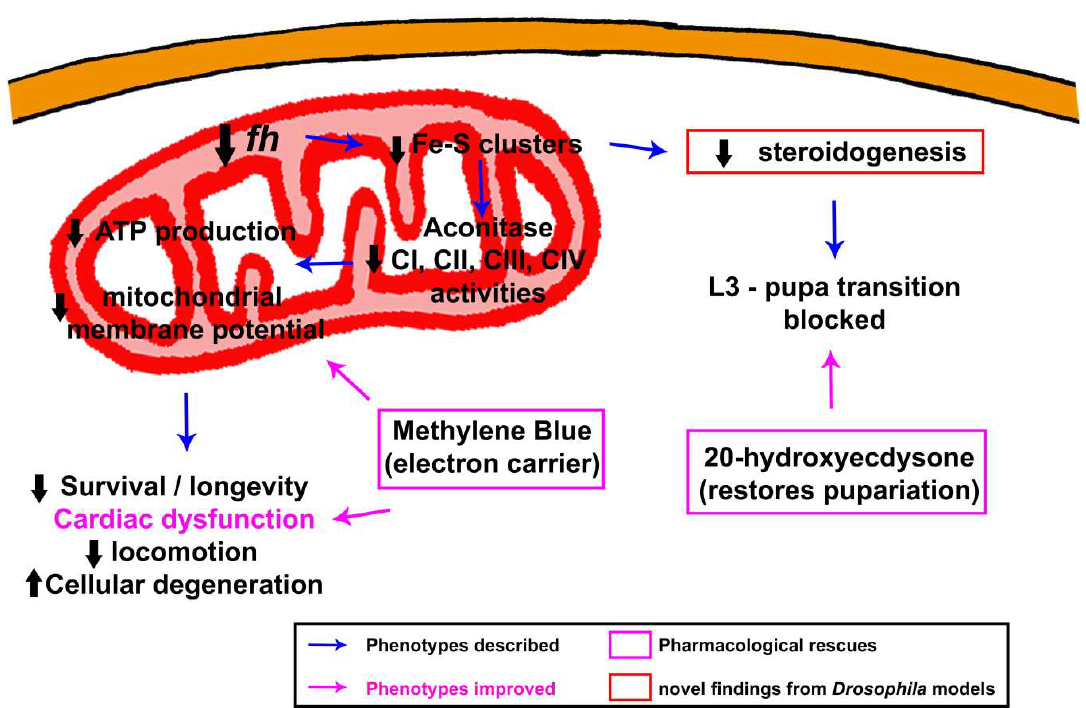
Figure 1. Graphic summary of molecular defects and rescues described in Drosophila melanogaster models of frataxin-deficiency in relation to Fe–S clusters generation and mitochondrial function.